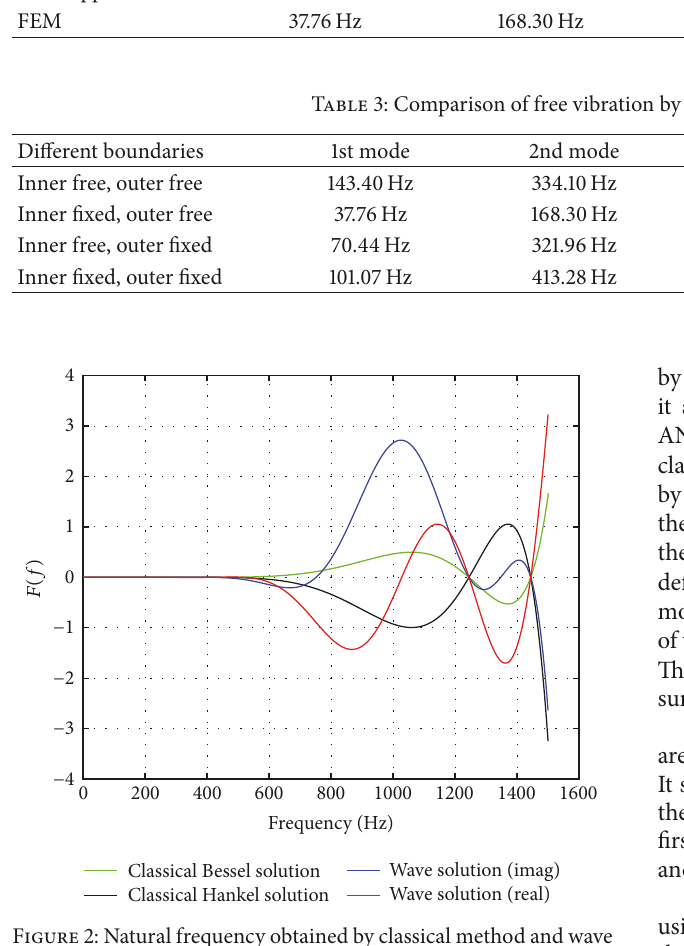
Figure 2: Natural frequency obtained by classical method and wave